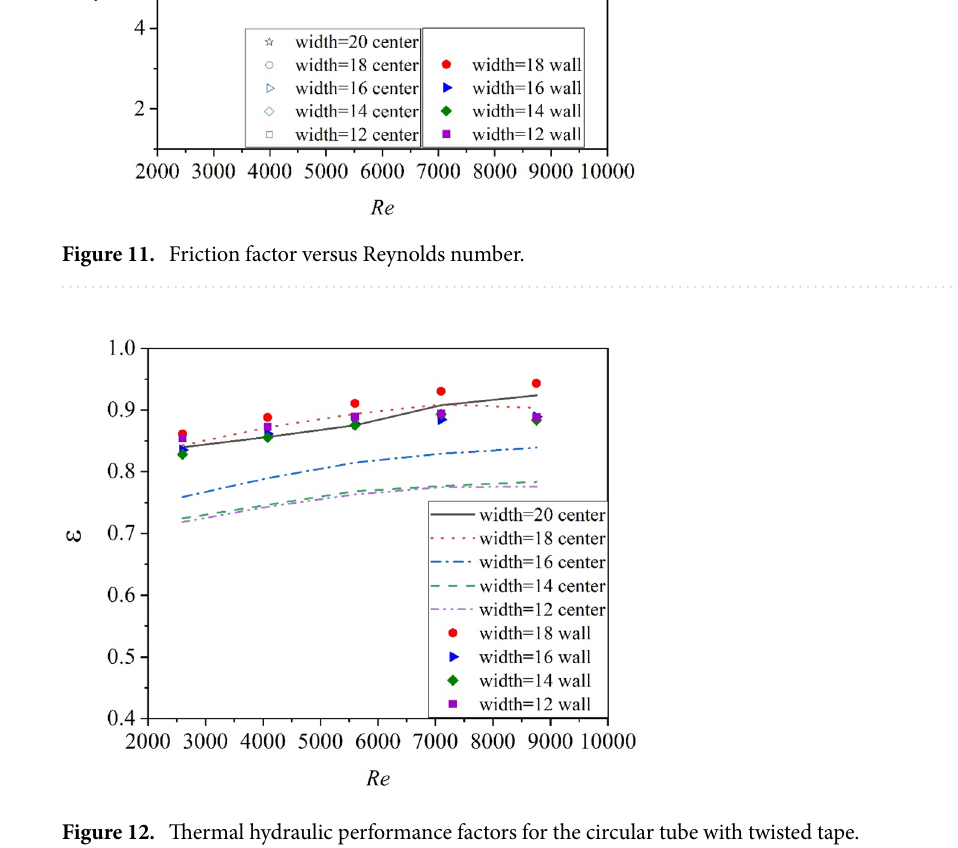
Figure 12. Thermal hydraulic performance factors for the circular tube with twisted